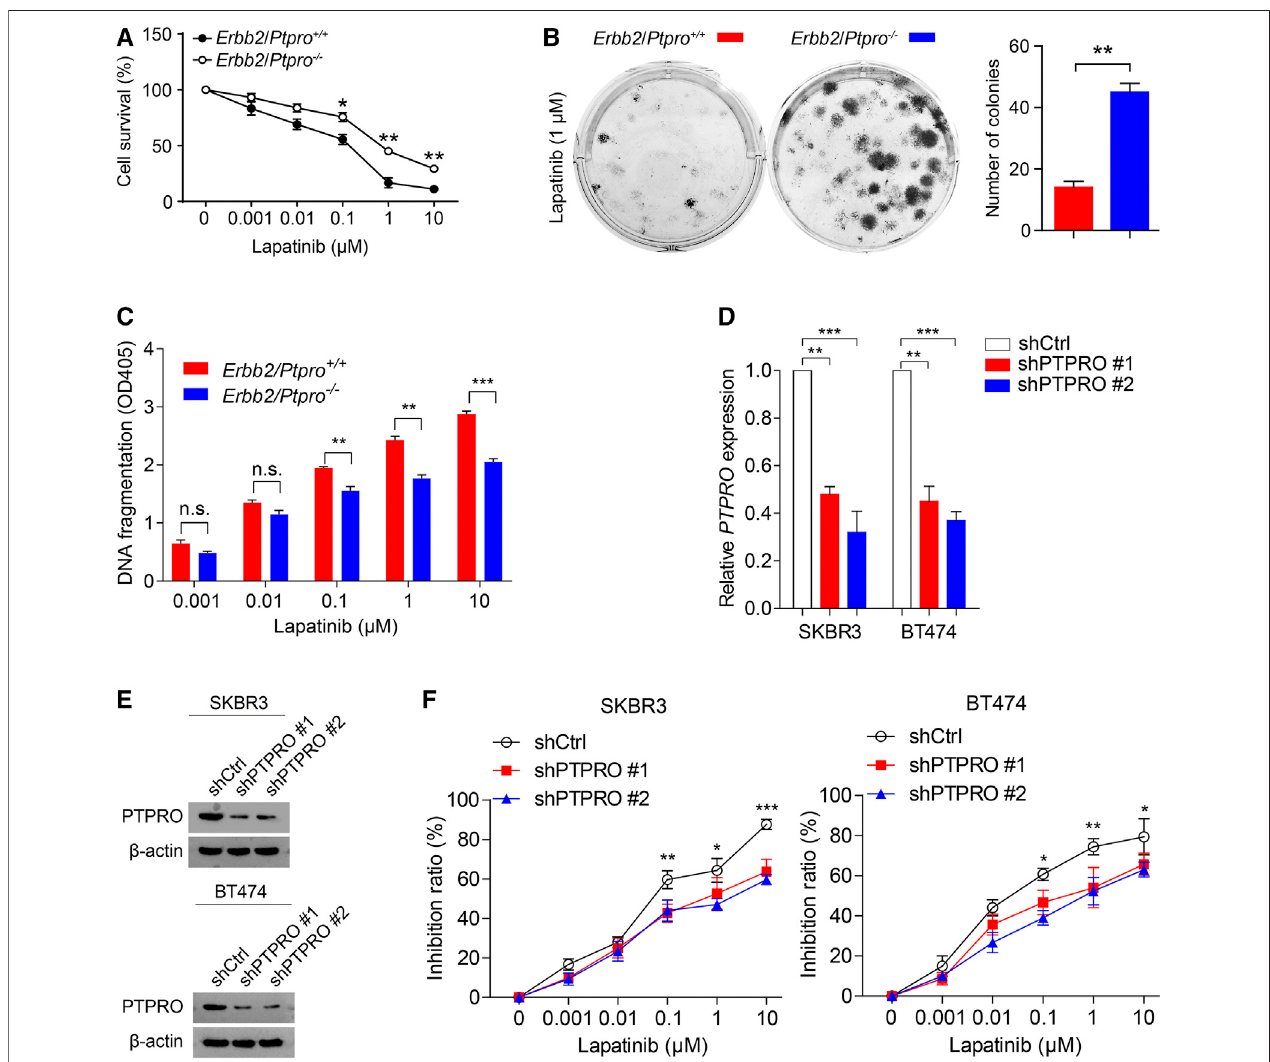
FIGURE 2 | PTPRO de fi ciency reduces lapatinib sensitivity in Ptpro − / − and littermate-control MEFs stably transfected with Erbb2 and ERBB2-positive breast cancer cells. (A) Erbb2 / Ptpro +/+ MEFs and Erbb2 / Ptpro − / − MEFs were plated in 96-well plates and treated with 10-fold serial dilutions of lapatinib ranging from 0.001 to 10 μ M for 72 h. The percentage cell viability was evaluated by MTT assay. (B) Erbb2/Ptpro +/+ MEFs and Erbb2/Ptpro − / − MEFs were incubated with lapatinib (1 μ M) for 2 weeks to allow colony formation (left panel) and the number of colonies was compared (right panel; ** p < 0.01). (C) Erbb2/Ptpro +/+ MEFs and Erbb2/Ptpro − / − MEFswereincubatedwithlapatinibrangingfrom0.001to10 μ Mfor72 h.CelldeathwasdeterminedusingaCellDeathdetectionELISAandabsorbancewasmeasured at 405 nm. (D) RT-qPCR of PTPRO in SKBR3 and BT474 cells with PTPRO depleted. (E) The protein level of PTPRO in SKBR3 and BT474 cells with PTPRO knockdown were analyzed by western blot. (F) Cell inhibition ratio analysis of SKBR3 and BT474 cells with PTPRO depleted was evaluated by MTT assay, 72 h after treatmentwith10-foldserialdilutionsoflapatinibrangingfrom0.001to10 μ M.Datawereshownasthemeansofthreeindependentexperimentsorrepresentativedata. Error bars indicate SEM; n.s., not statistically signi fi cant; * p < 0.05, ** p < 0.01, *** p < 0.001 by Student ’ s t-test or a one-way ANOVA with post hoc intergroup comparisons, where appropriate.